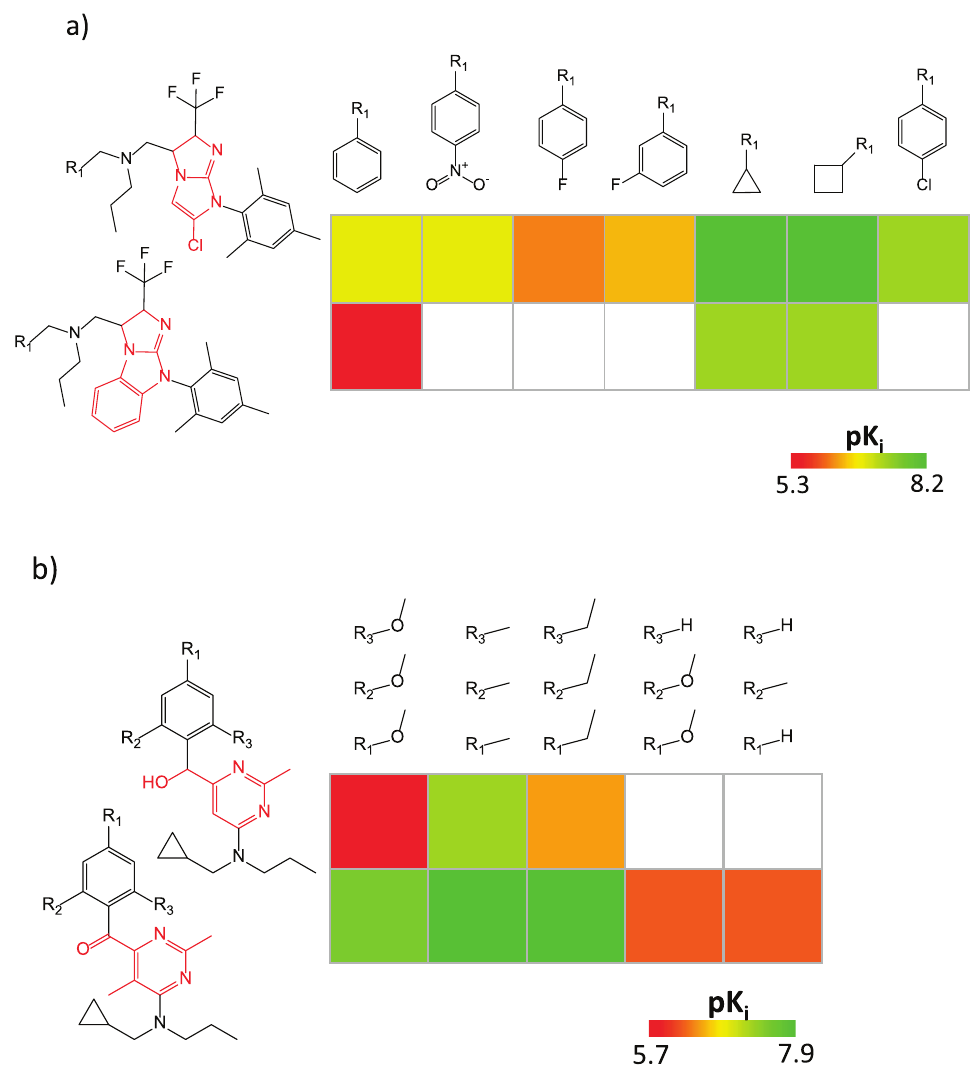
Figure 4. Ranked SAR matrices. In ( a ) and ( b ), two SARMs are shown (resulting from single- and triple-cut fragmentation, respectively) for corticotropin-releasing factor receptor 1 ligands that were highly ranked on the basis of SAR discontinuity scoring.